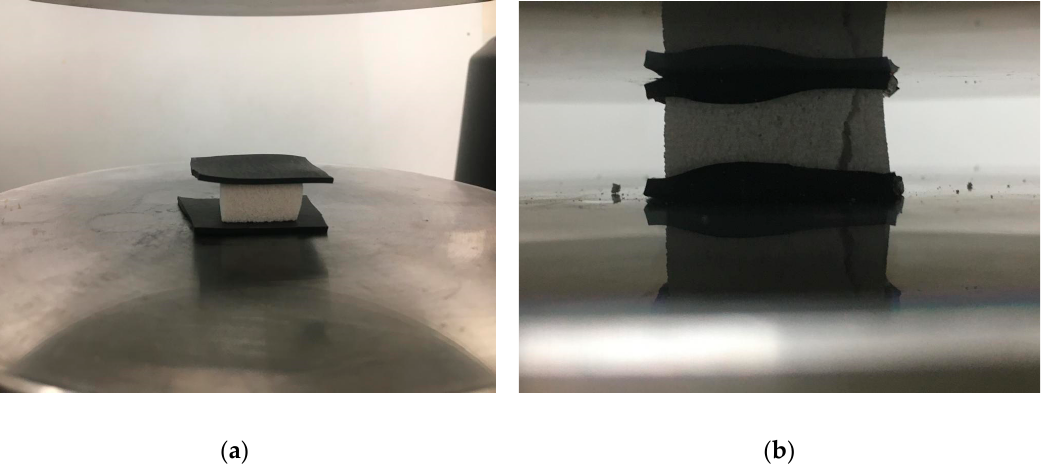
Figure 1. Experimental setup for crushing strength measurements: ( a ) prior to testing and ( b ) crack failure event during testing.